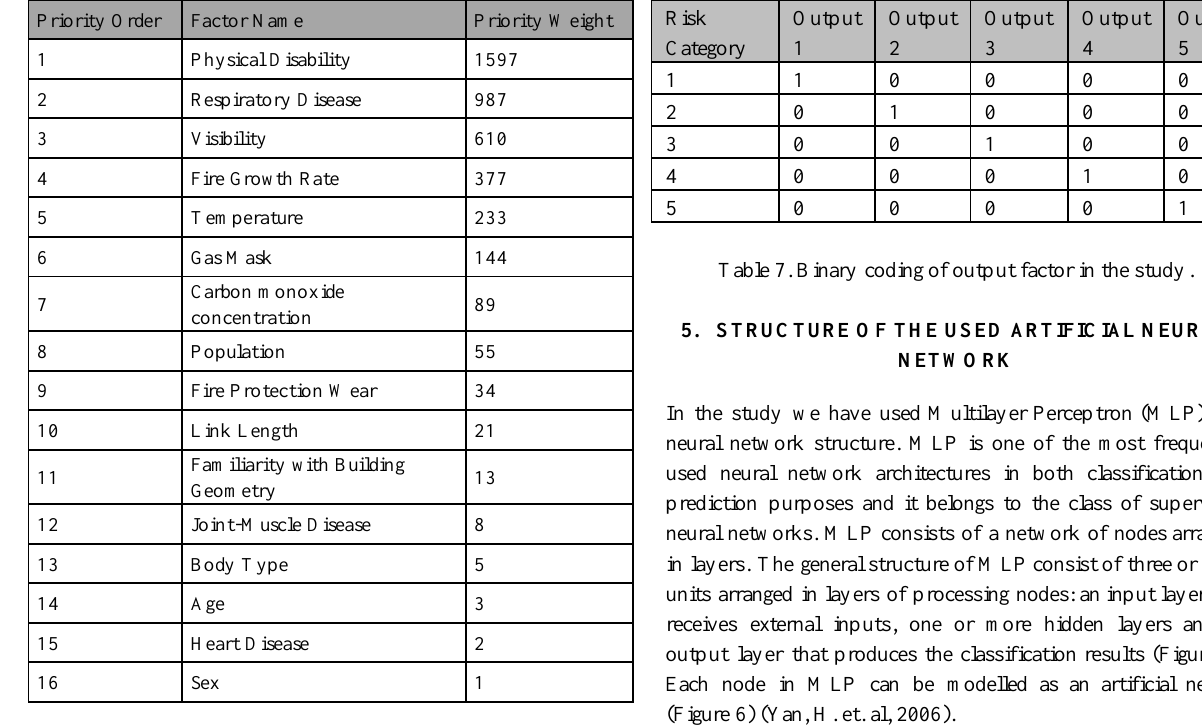
Table 5. Priority order of the factors affecting the fire response performance.